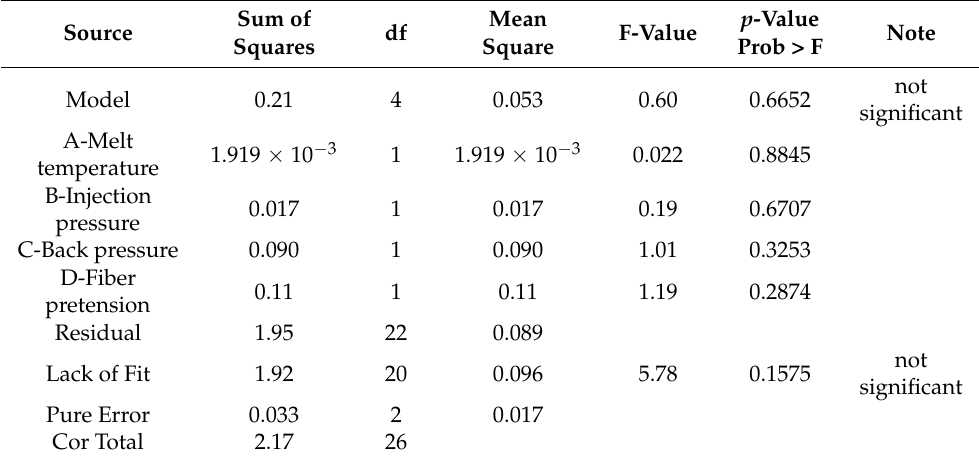
Figure 8. Experimental results: ( a ) fiber volume fraction; ( b ) impact strenght; and ( c ) flexural strength. Table 5. ANOVA for fiber volume